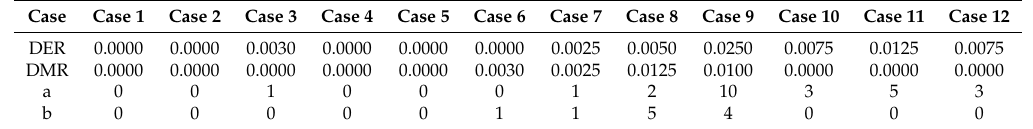
Table 3. The detection error rate (DER) and detection missing rate (DMR) results of simulated experiments. Case